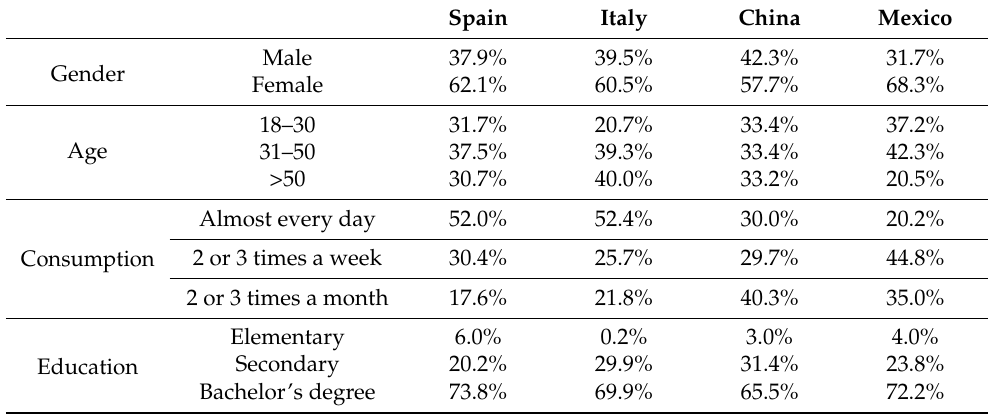
Table 1. Demographic data of the participants from each country expressed as a